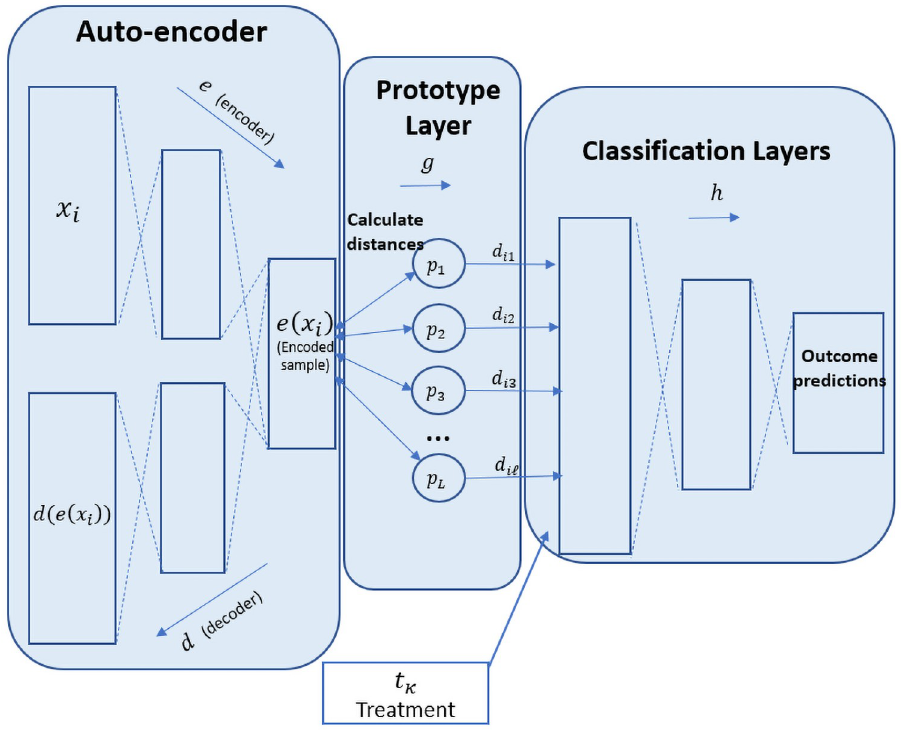
Fig 1. Visualisation of the DPNN